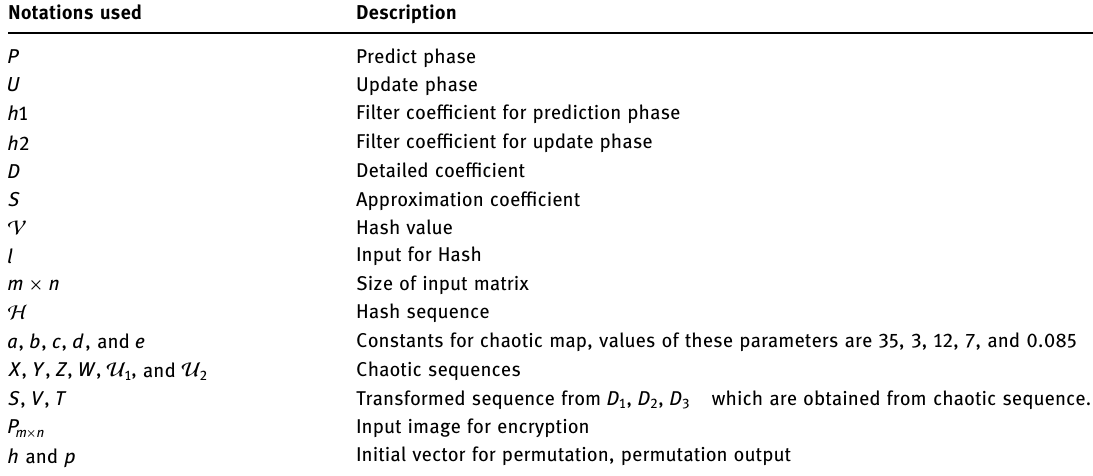
Table 1: Notations used in the